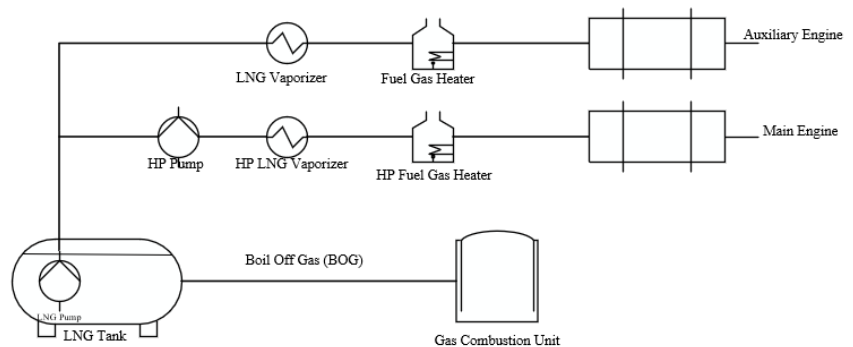
Figure 6. Configuration of FGSS with BOG handled by GCU.